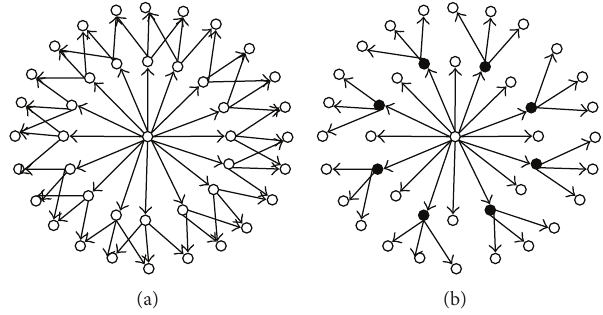
Figure 2: Comparison of full flooding (a) and MPR flooding (b).